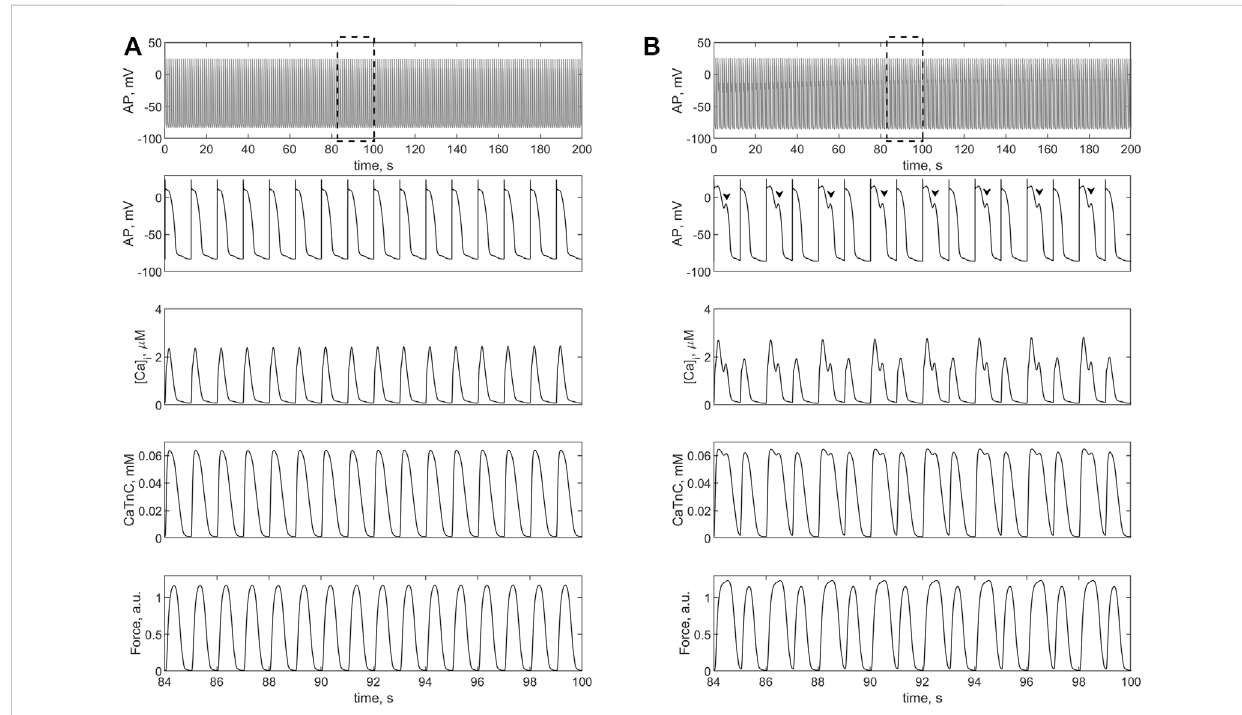
FIGURE 7 Isometric contractions of a cardiomyocyte at a length of 90% L max in the case of a 1.4-fold increase (compared to the norm) in L-type calcium current conductance. (A) simulation in the TP + M model (i.e., without fi broblasts), where no triggered activity occurs. (B) simulation in model 2 with electromechanical interaction with four fi broblasts at ɡ gap = 3.0 nS. Upper panels: cardiomyocyte APs in thetime interval from 0to 200 satapacing rate of 1 Hz. Other panels: details of APs, Ca 2+ transients ( [Ca] i ), concentration of calcium-troponin complexes ( CaTnC ) and isometric force signals ( Force ) in the interval from 84 to 100 s, marked by dashed rectangles in the upper panels. The EADs in model 2 are shown by